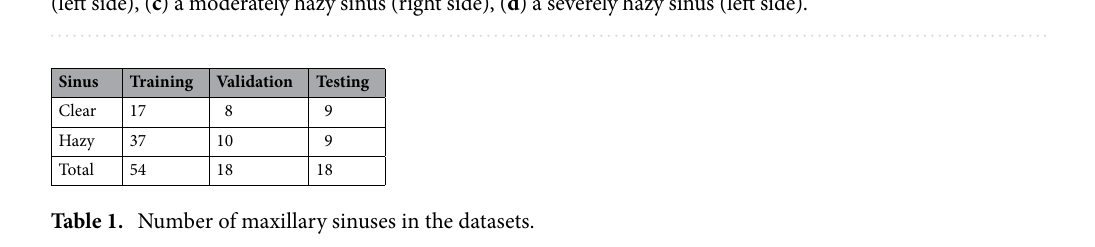
Figure 1. Examples of various maxillary sinus images. ( a ) Clear sinuses (both sides), ( b ) a slightly hazy sinus (left side), ( c ) a moderately hazy sinus (right side), ( d ) a severely hazy sinus (left side).